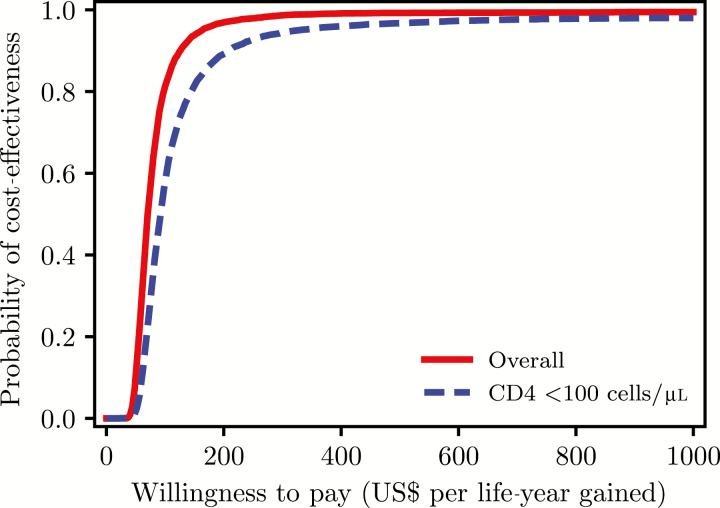
Cost-effectiveness acceptability curves showing the probability of cost-effectiveness at different willingness-to-pay thresholds according to baseline CD4 cell count.